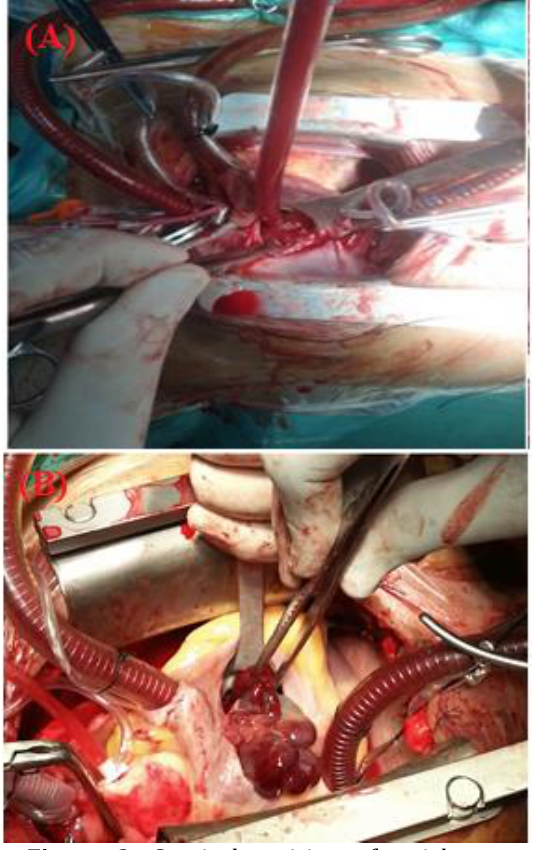
Figure 3: Surgical excision of atrial myxoma through sternotomy.